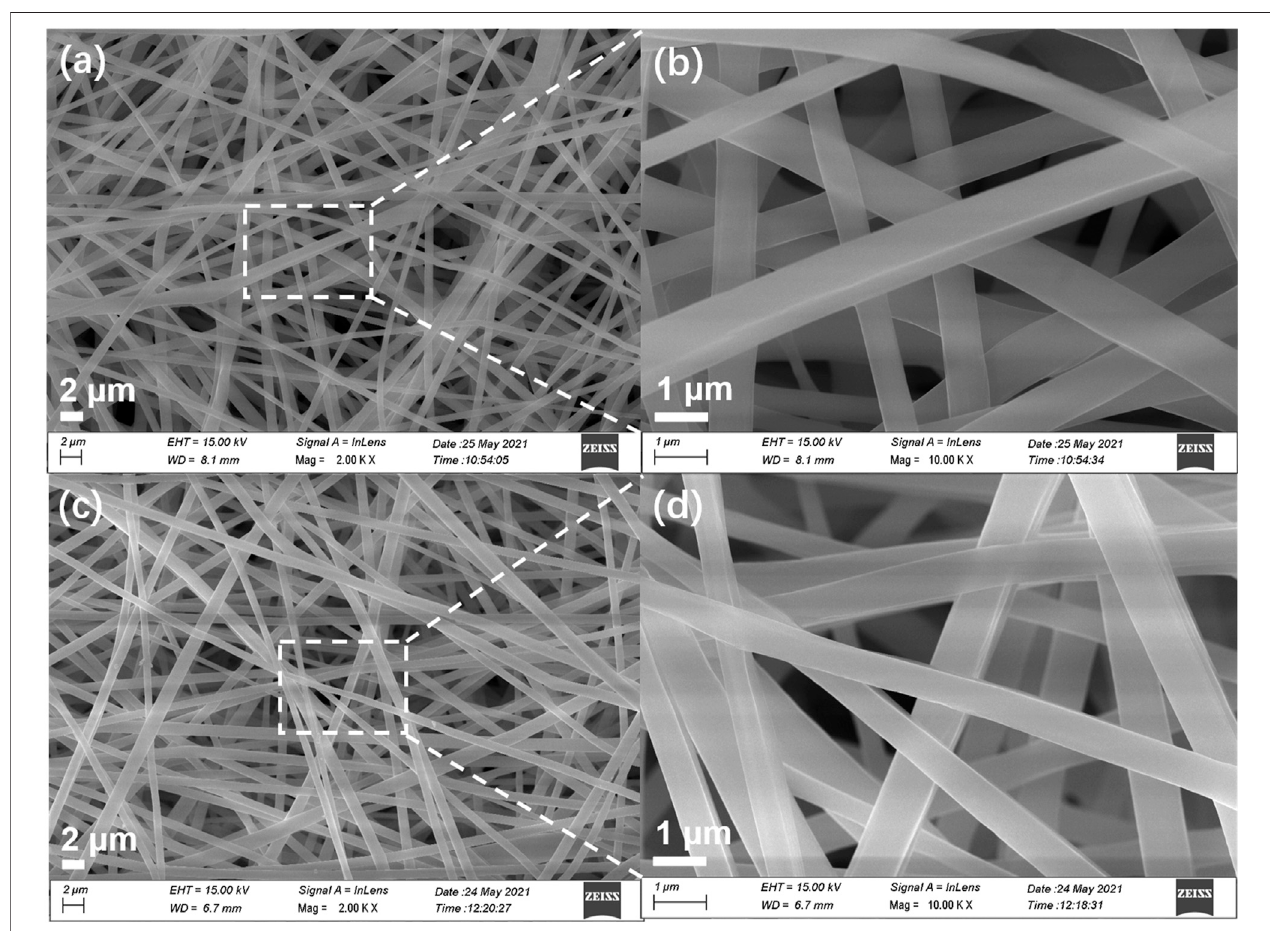
FIGURE 6 | SEM images of (A,B) PLA nano fi brous fi lm and (C,D) TPEBZMZ-m. (A,C) Large scale; (B,D) high resolution.